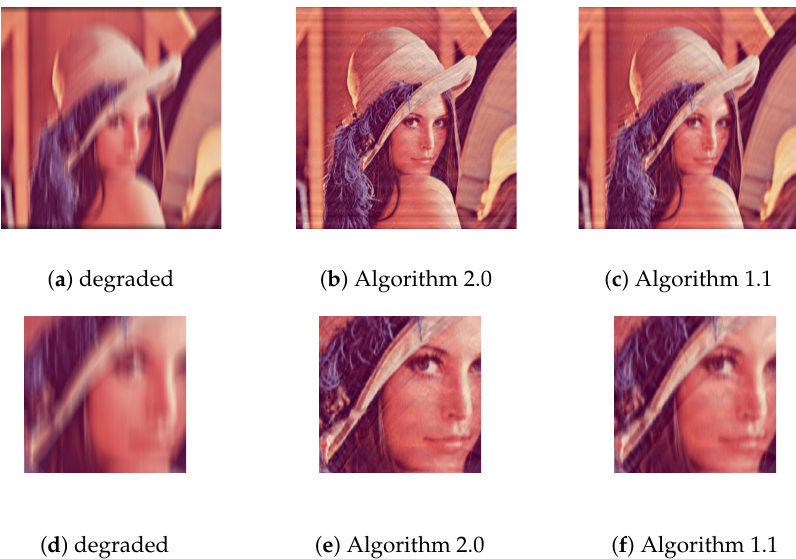
Figure 6. Degraded and restored ( a – c ) Lena images and ( d – f ) enlarged Lena images by the various